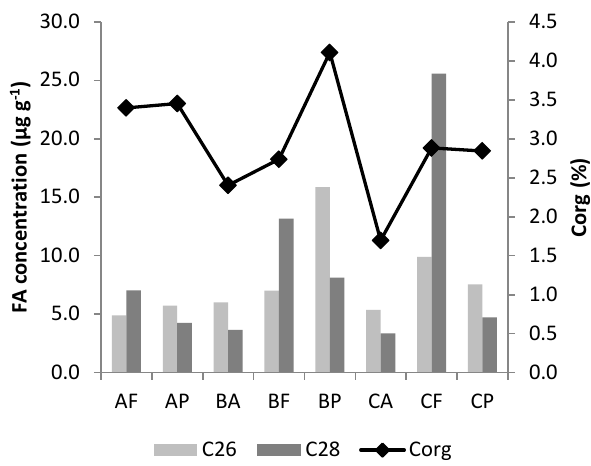
Figure 4. FA concentration compared to % C org at the source sites. The first letter gives the site notation (sites A, B, C) while the second letter indicates the land-use type (F is forest, P is pasture, A is arable